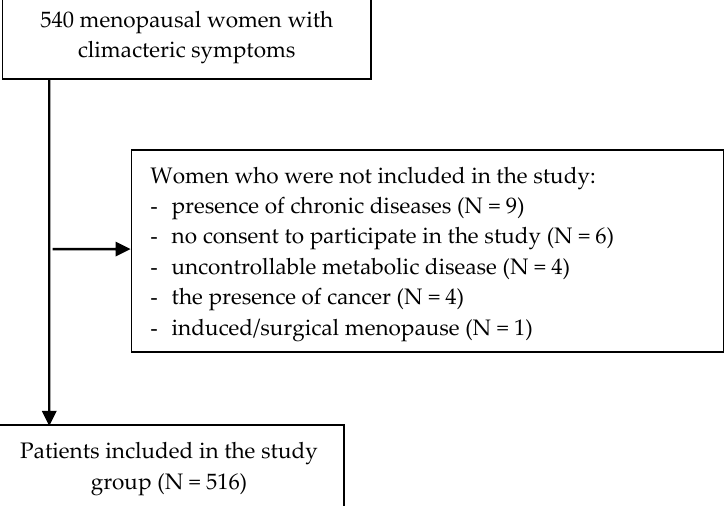
Figure 1. Flow diagram of exclusions and final analytic sample.